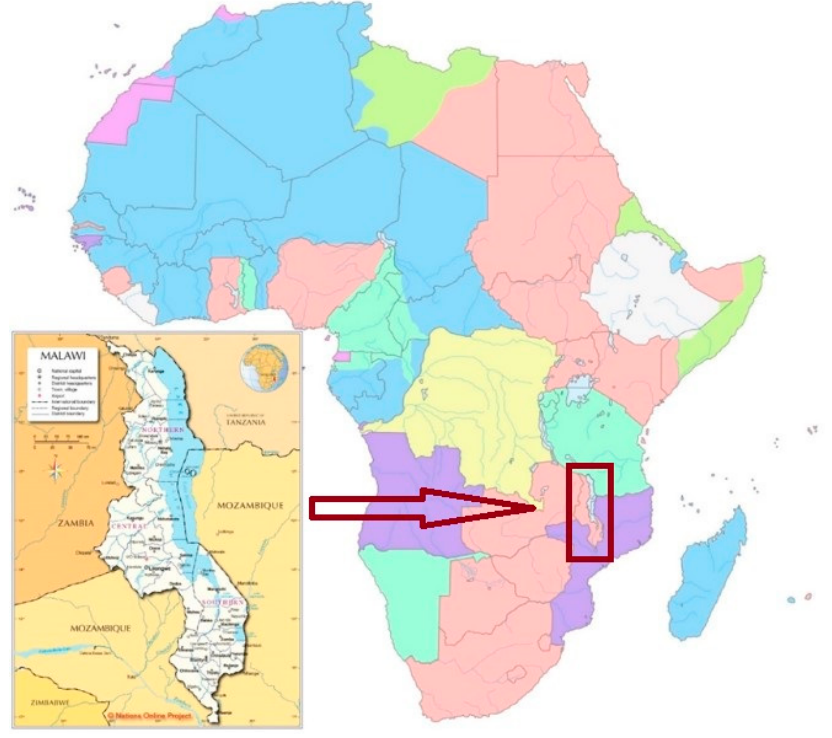
Figure 1. Geographical location of Malawi in Africa [3,4].